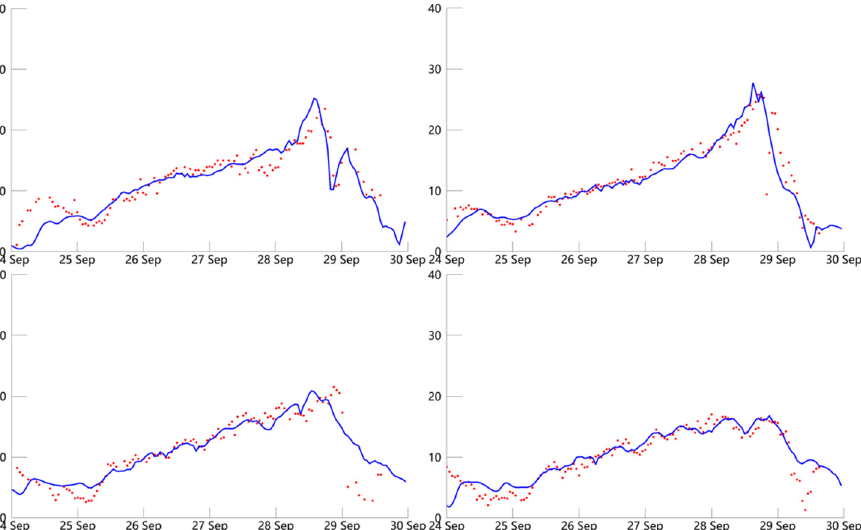
Figure 4. The temporal distributions of wind speeds (m/s) obtained from experiment 12 (blue line) and the buoy observations (red dot) during typhoon Dujuan at the locations of four buoys.